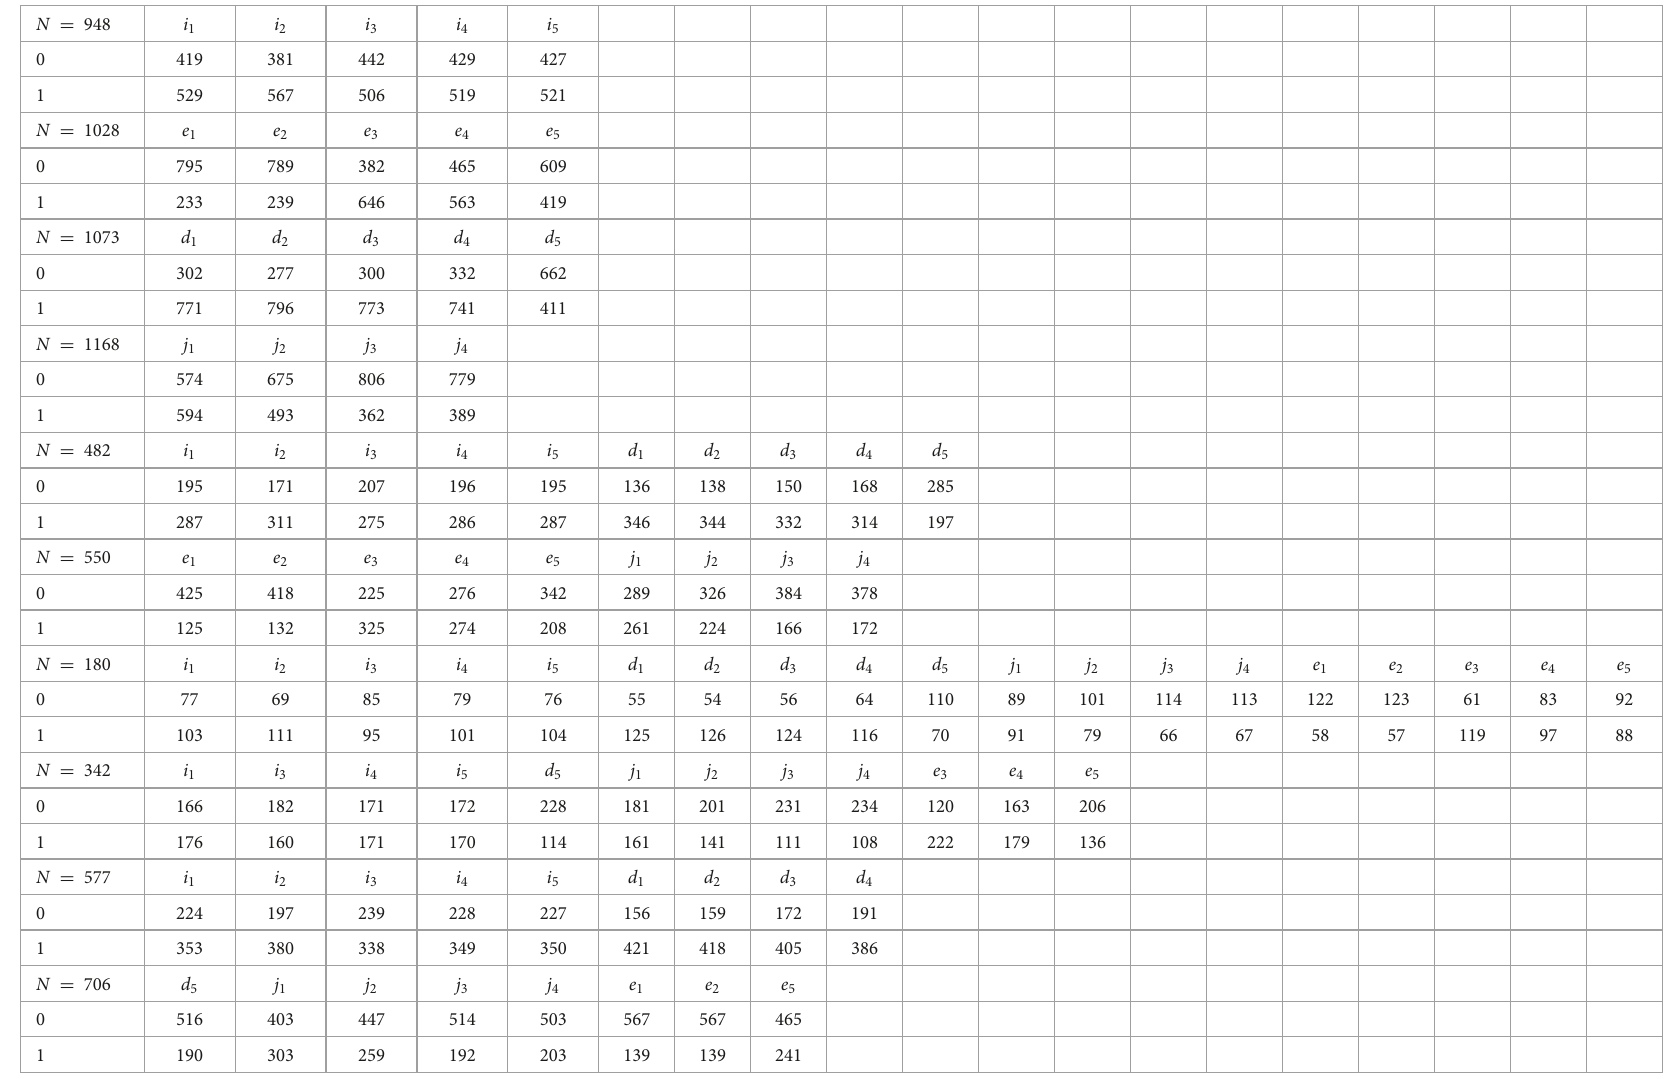
TABLE 2 Frequency distributions of the dichotomous scores across motivation variables of, from top to bottom, the individual regulation types, of autonomous motivation and controlled motivation, of the entire motivation domain, and the subsets A , B , and C of the data set,